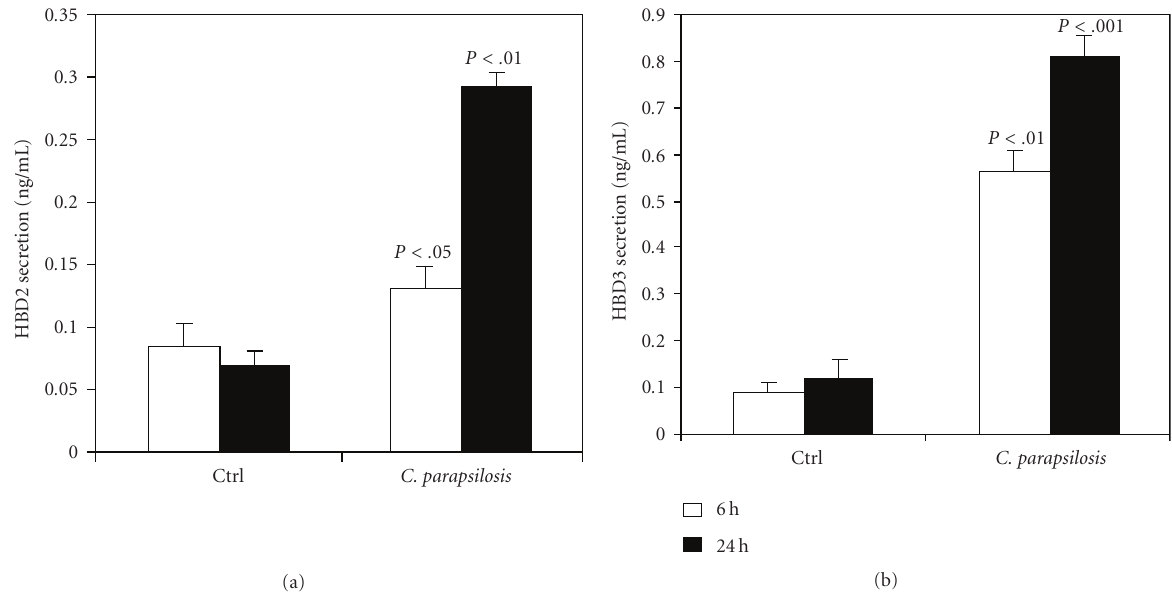
Figure 7: Quantification of HBD2 and HBD3 levels secreted by gingival epithelial cells following infection with C. parapsilosis . Gingival epithelial cells were cultured with or without C. parapsilosis for 6 and 24 hours. Supernatants were collected and used to quantify HBD2 (a) and HBD3 (b) using ELISA kits. Data are means ± SD of three separate experiments. The levels of significance were obtained by comparing the amount of AMP obtained with unstimulated samples to that obtained with samples stimulated C.